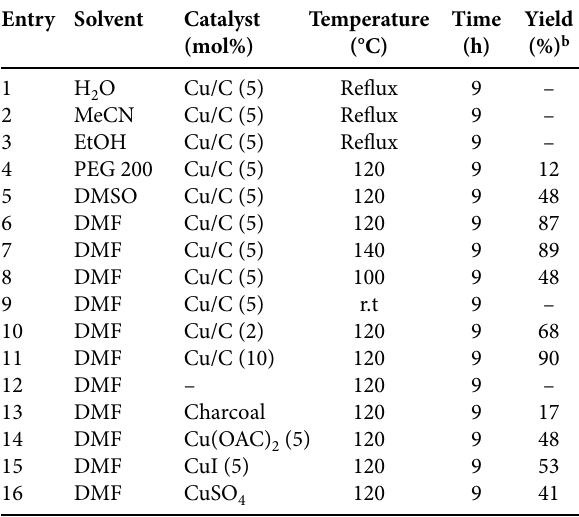
Table 1. Optimization for the synthesis of tetrazole from aldehyde. a